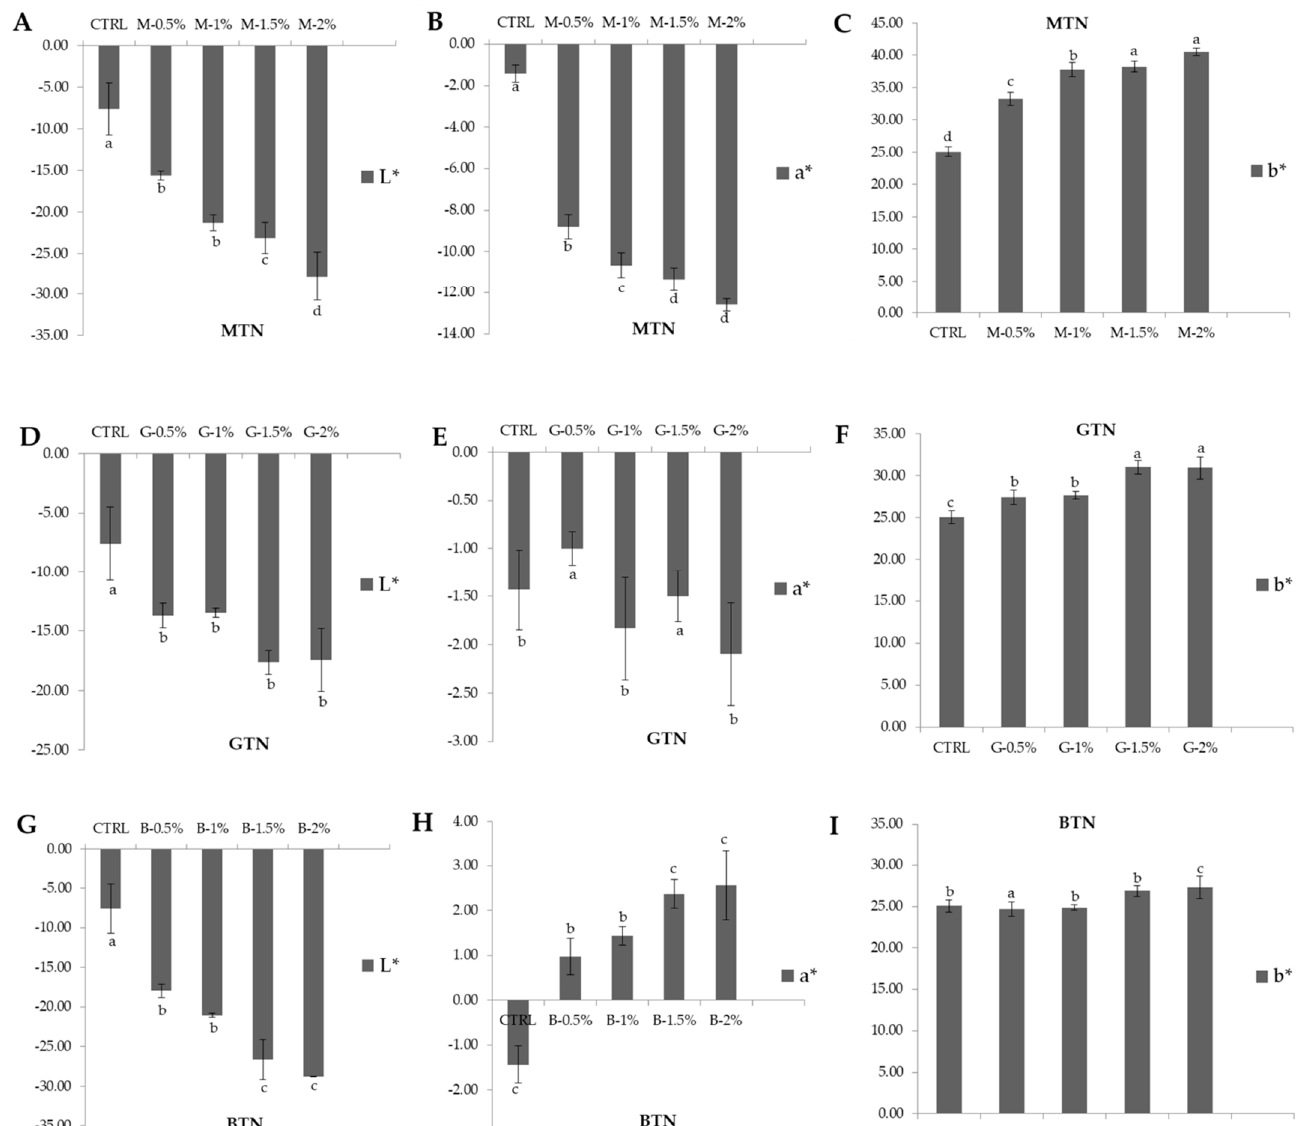
Figure 1. Color analysis of noodle samples: ( A ) Matcha tea noodles (MTN) brightness (L*) in color; ( B ) Matcha tea noodles (MTN) greenness (-a*) in color; ( C ) Matcha tea noodles (MTN) yellowness (b*) in color; ( D ) Green tea noodles (GTN) brightness (L*) in color; ( E ) Green tea noodles (GTN) greenness (-a*) in color; ( F ) Green tea noodles (GTN) yellowness (b*) in color; ( G ) Black tea noodles (BTN) brightness (L*) in color; ( H ) Black tea noodles (BTN) redness (a*) in color; ( I ) Black tea noodles (BTN) yellowness (b*) in color. CTRL: noodles without tea powder; M-0.5%, M-1.0%, M-1.5%, and M-2.0%: noodles with additional 0.5%, 1.0%, 1.5%, and 2.0% matcha tea powder, respectively; G-0.5%, G-1.0%, G-1.5%, and G-2.0%: noodles with additional 0.5%, 1.0%, 1.5%, and 2.0% green tea powder, respectively; B-0.5%, B-1.0%, B-1.5%, and B-2.0%: noodles with additional 0.5%, 1.0%, 1.5%, and 2.0% black tea powder, respectively; All addition levels were on a flour basis. The values followed by different letters were significantly different ( p < 0.05).